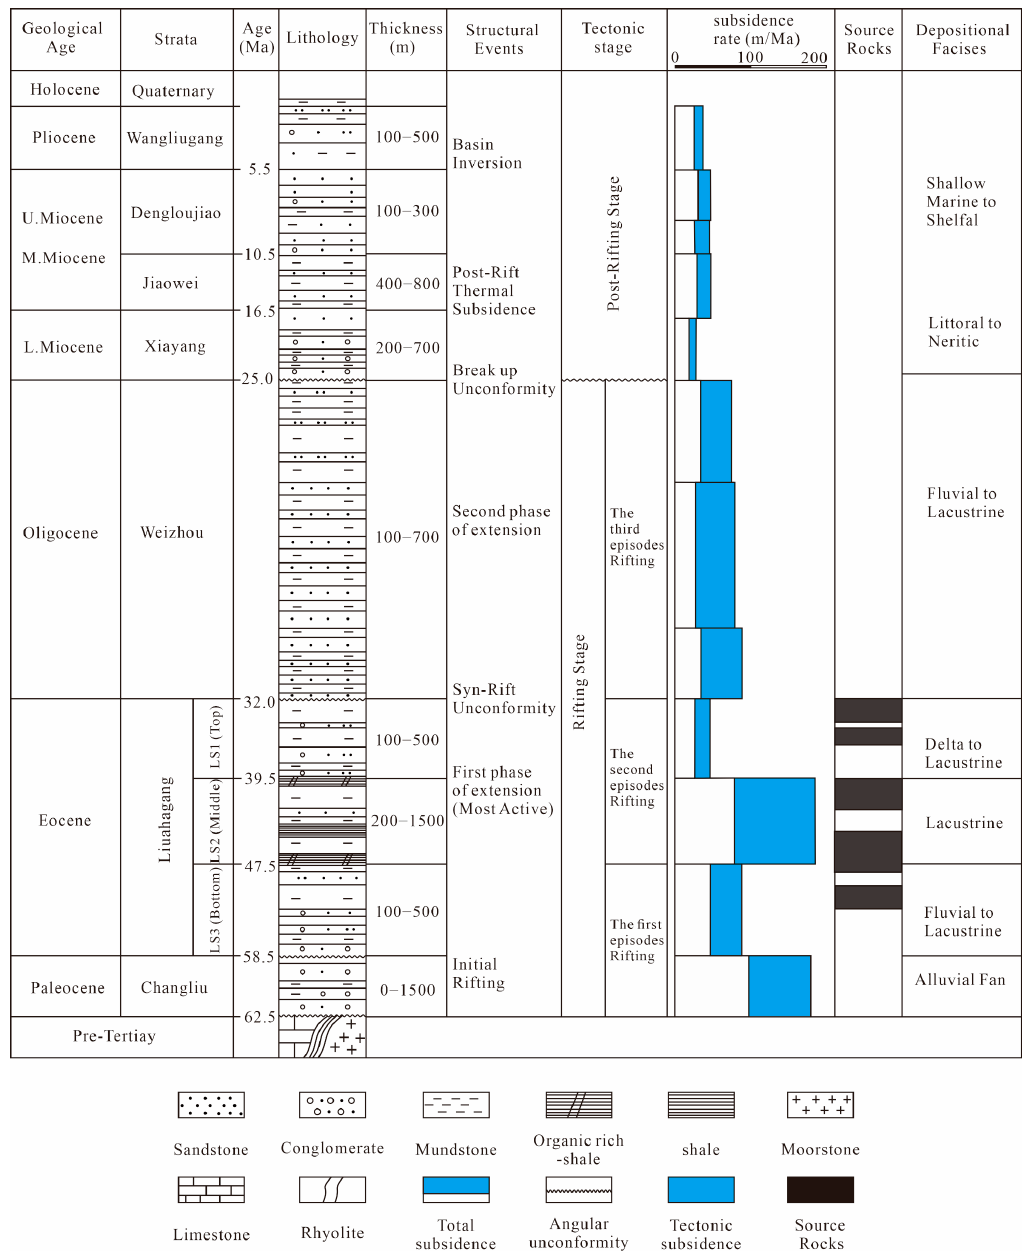
Figure 3. Schematic view showing the stratigraphic column of the Beibuwan Basin (modi fi ed from Refs.[7,9]. Refs.